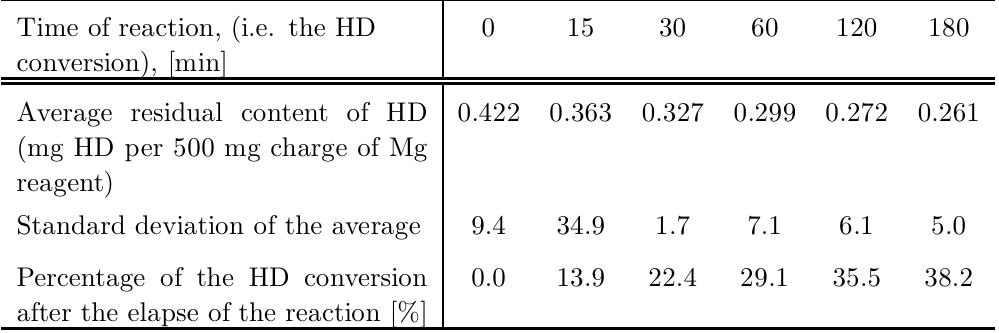
Table 6 Time dependence of the mustard conversion on Mg 25/2/380 sample (the Mg reagent charge of 500 mg, 0.42 mg of HD in 0.1 ml of petrolether, temperature of 25 ¯